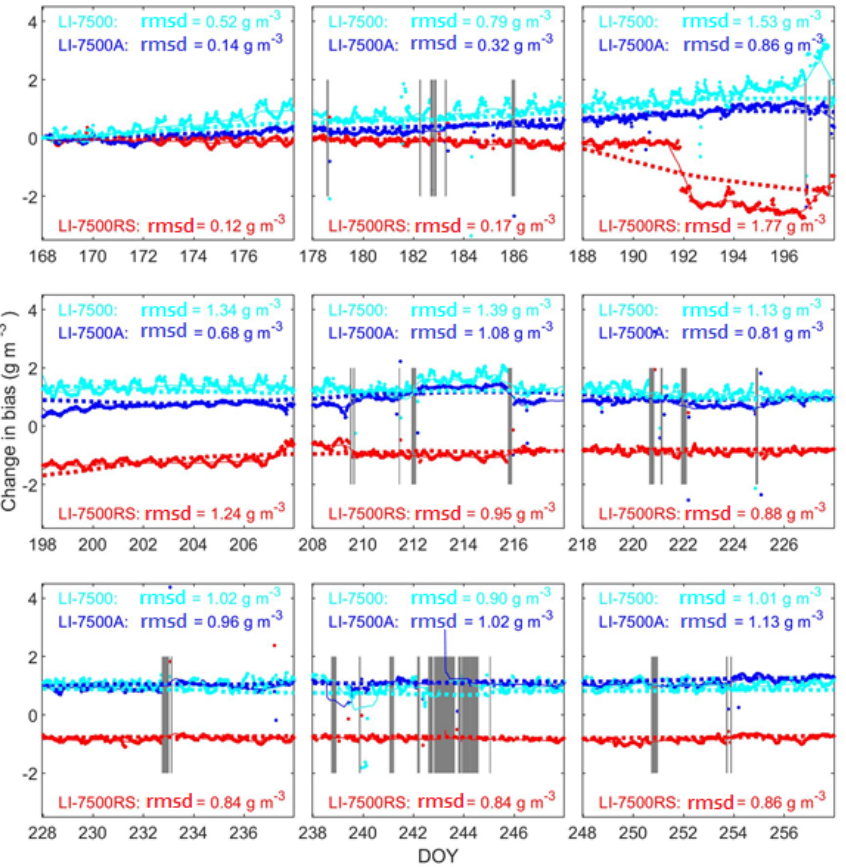
Figure 3. Evolution of absolute humidity bias over nine 10d periods, shown as half-hour bias ρ v (points) and 1d (thin solid lines) and 10d (dotted lines) moving averages. Half hours with observed rainfall are indicated with vertical